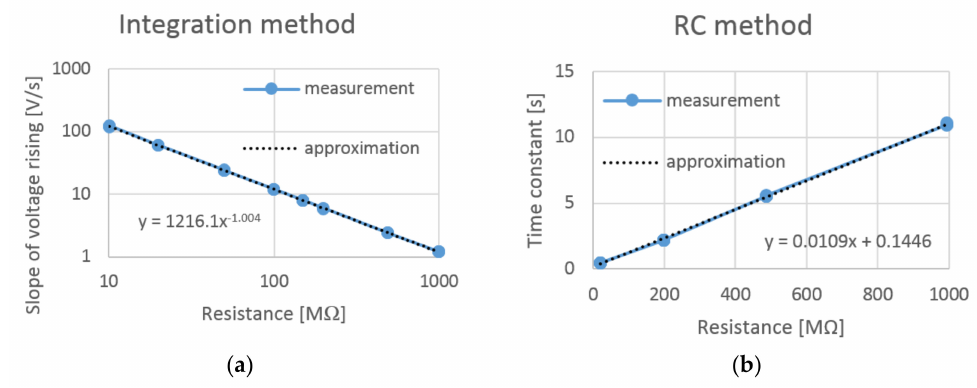
Figure 8. Calibration of ( a ) integrator and ( b ) RC circuit.